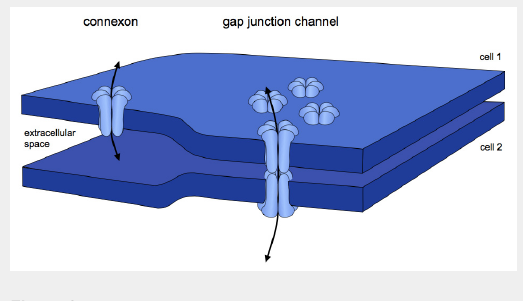
Connexins form connexons composed of six connexins in the Golgi apparatus. Thereafter, connexons can be inserted in the plasma membrane where they can function as connexons (hemi-channels; left) or as gap junctions (right) if they dock to a connexon expressed by a neighbouring cell. Connexons allow exchange of small molecules (<1000 Da) between the cytosol and the extracellular space. Gap junctions allow passage of similar molecules between adjacent